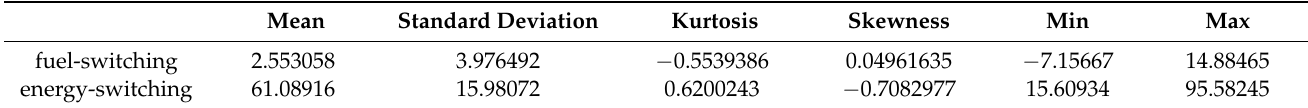
Table 1. Summary statistics of fuel-switching and energy-switching